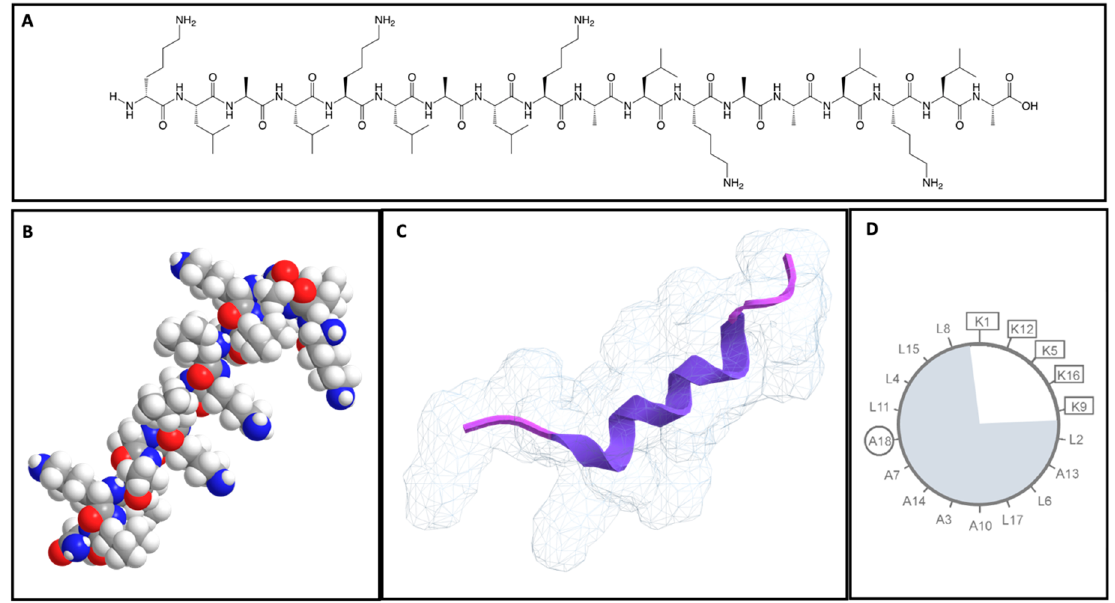
Figure 2. Different representations of peptide MAPs. ( A )—Structure sequence of MAP (ChemDraw 19.0); ( B )—Three-dimensional representation of MAP sequence (ChemBio 3D ultra); ( C )—Secondary structure (in carton) and an H 2 O mesh surface of MAP (3D data retrieved from CPP database (CPPsite 2.0) and analyzed by ChemBio 3D ultra); ( D )—Projection wheel of MAP (hydrophobic part is blue-shaded and charged residues are highlighted with